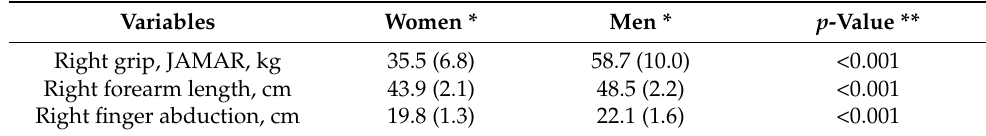
Table 3. Right-hand grip strength, forearm length and finger abduction comparison between women and